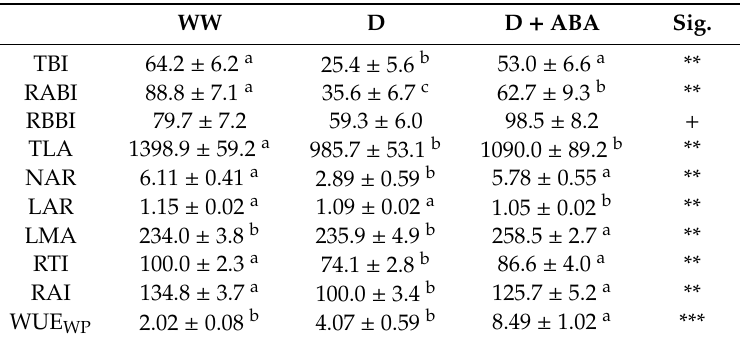
Table 2. Total biomass increase (TBI, %), relative aboveground biomass increase (RABI, %), relative belowground biomass increase (RBBI, %), total leaf area (TLA, cm 2 plant − 1 ), net assimilation rate (NAR, g m − 2 day − 1 ), leaf area per total plant biomass (LAR, m 2 kg − 1 ), leaf mass area (LMA, g m − 2 ),